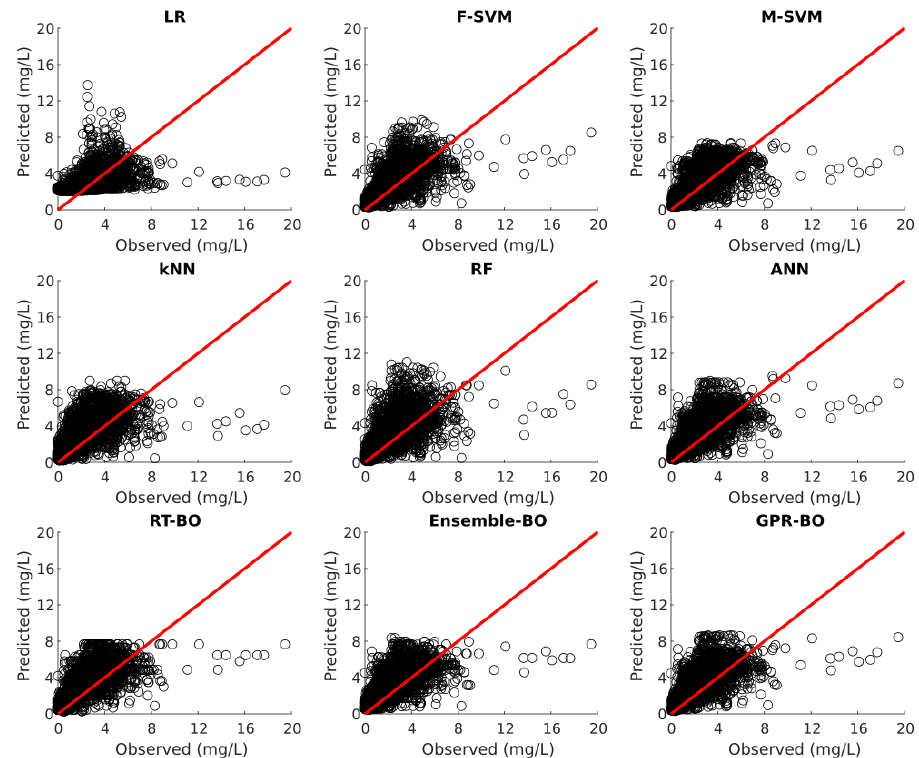
Figure 5. Observed versus predicted daily nitrate concentration for Raisin using different ML algo-